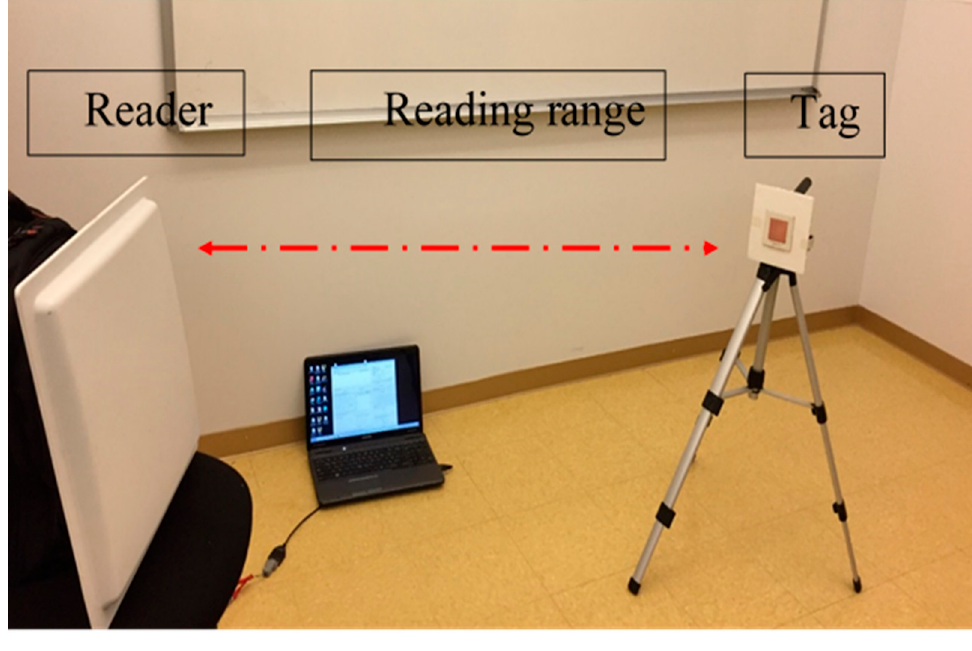
Figure 6. Measured reading range.